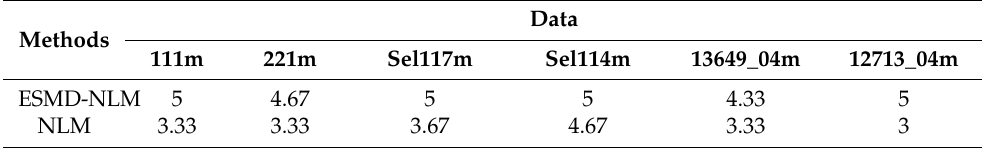
Table 4. The MOS values for the ESMD-NLM and NLM methods operating on the six groups of clinical ECG signals.